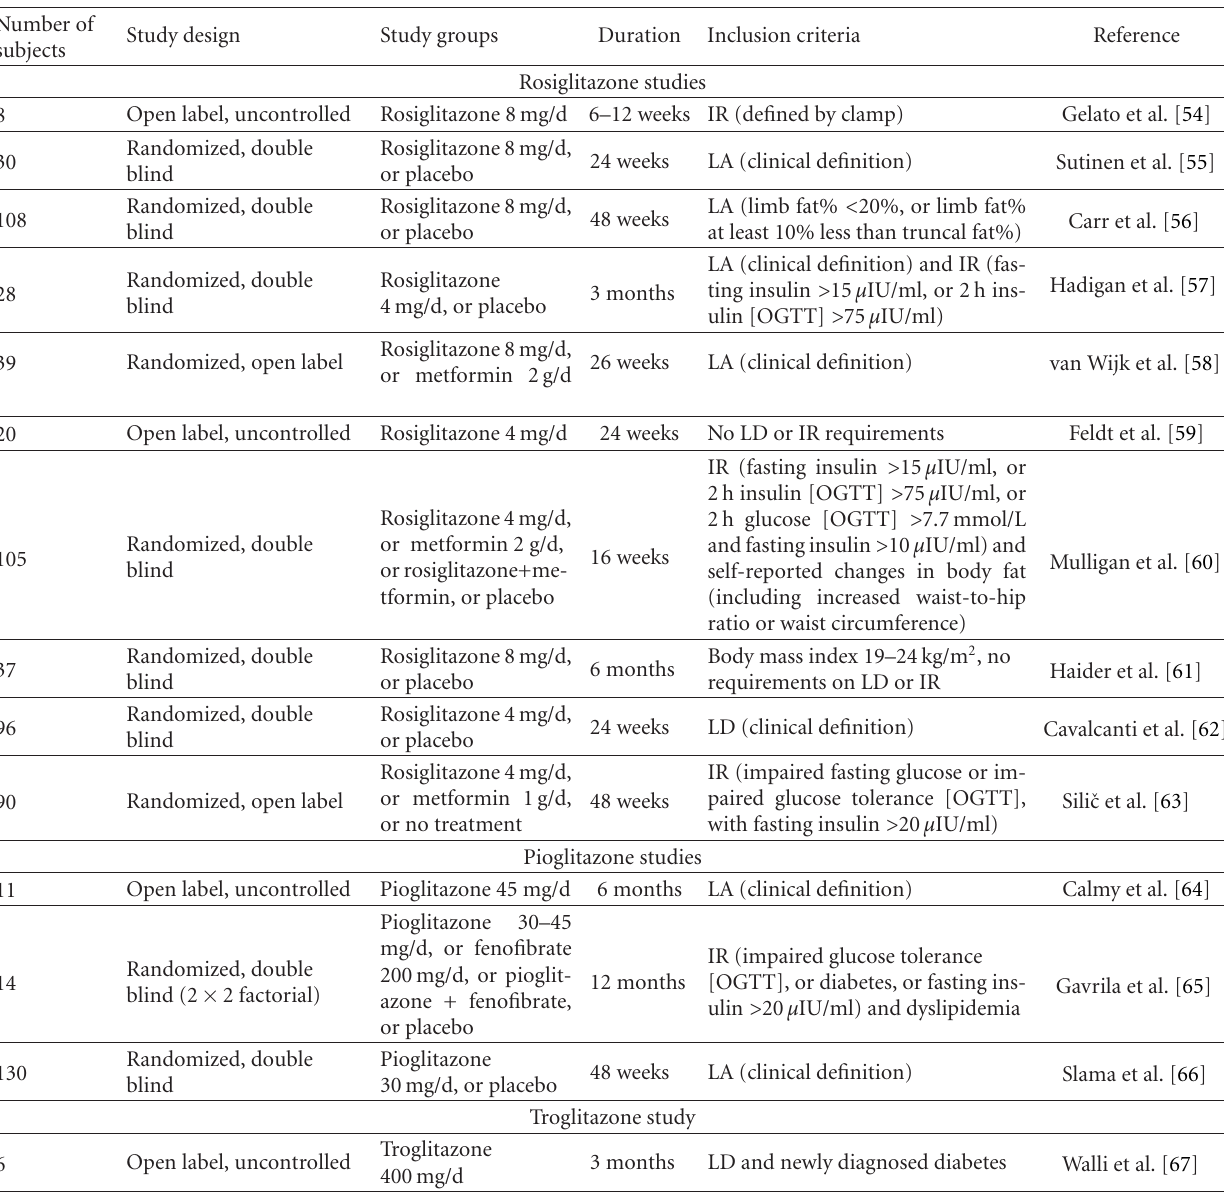
Table 1: The basic characteristics of the studies with thiazolidinediones in HIV-infected, HAART-treated patients. HAART = highly active antiretroviral therapy, IR = insulin resistance, LA = lipoatrophy, OGTT = oral glucose tolerance test, LD =